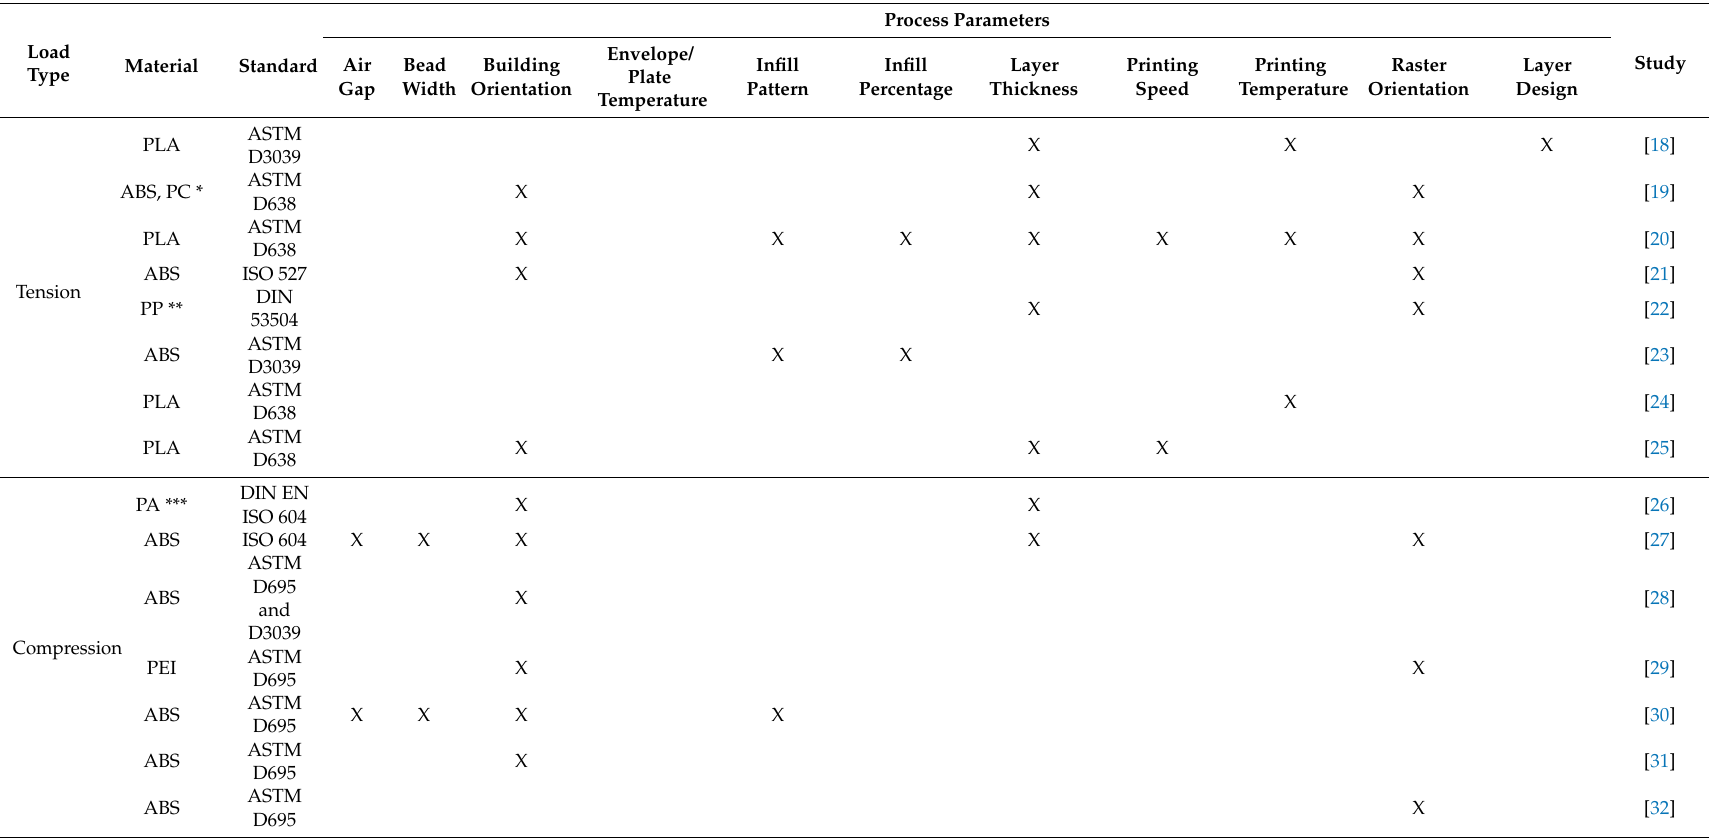
Table 1. Studies on mechanical testing of material extrusion (ME) printed test specimens. PLA—polylactic acid; ABS—acrylonitrile butadiene styrene; ASTM—American Society for Testing and Materials; ISO—International Organization for Standardization; DIN—Deutsches Institut für Normung;